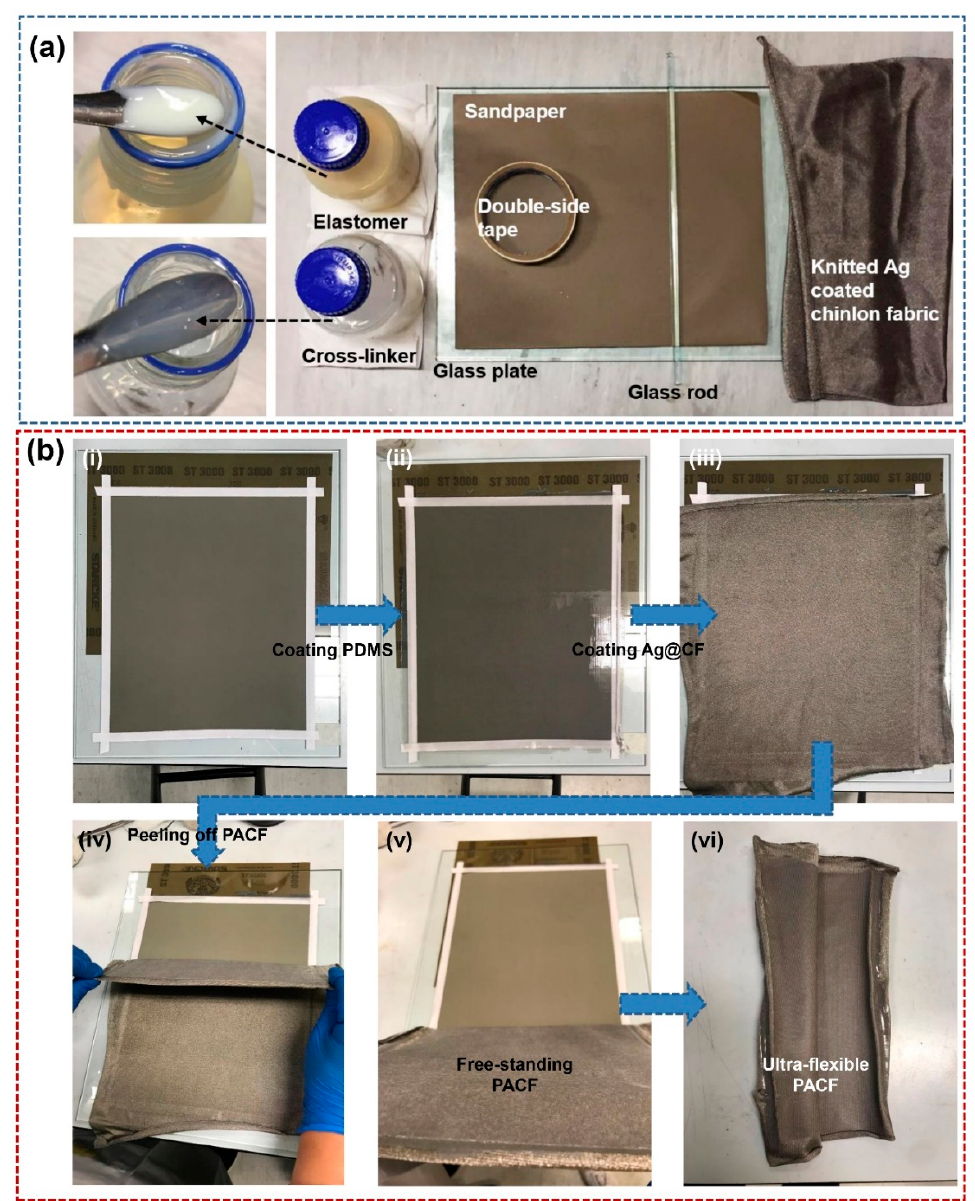
Figure 1. ( a ) Materials and fabrication equipment. ( b ) Schematic illustration of one-step fabrication process for PDMS-based Ag@CF composite film.